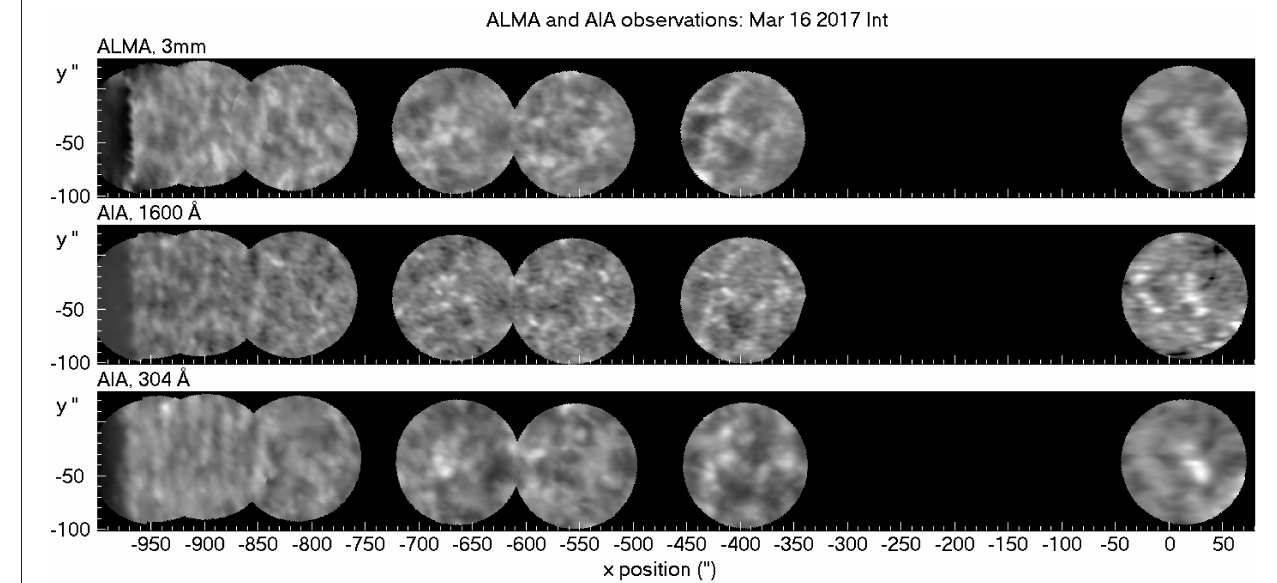
FIGURE 2 | The top row shows a composite (oriented in the south-east direction with respect to solar north) of seven 3 mm average ALMA images (each one computed from visibilities of duration 10 min) while the second and third rows show composites of AIA 1,600 and 304 Å average images for the same fields of view and time intervals as the ALMA images. The AIA images have been convolved with the ALMA beam (from Nindos et al., 2018). Reproduced with permission ©